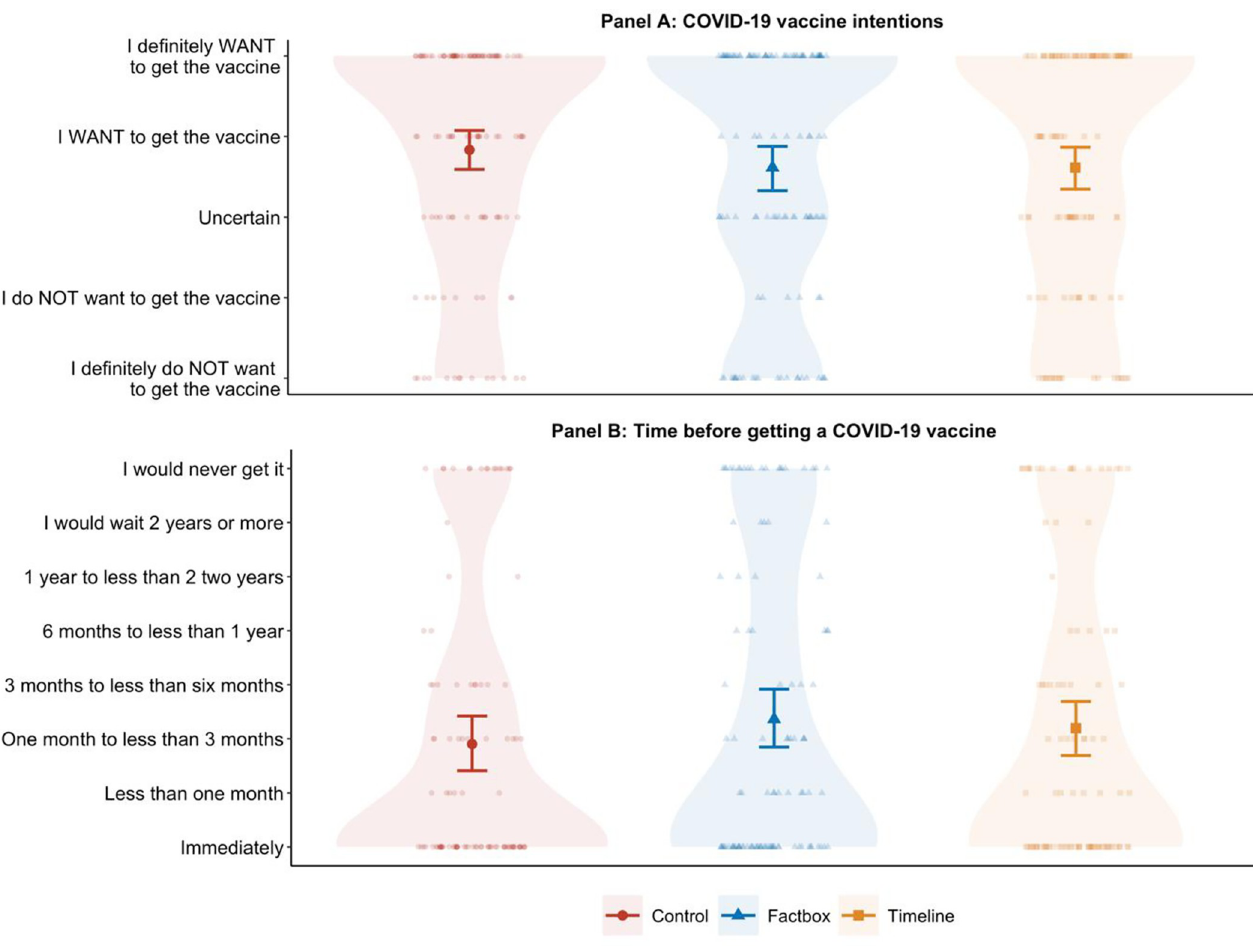
Fig 2. Mean COVID-19 vaccine intention scores for the factbox message (showing risk of getting COVID-19 versus risk of getting a COVID-19 vaccine), the timeline message (showing the development of mRNA and COVID-19 vaccine research), and control group. The middle bold line represents the mean and the error bars represent 95% confidence intervals. Individual data points are displayed along with shaded density distributions.